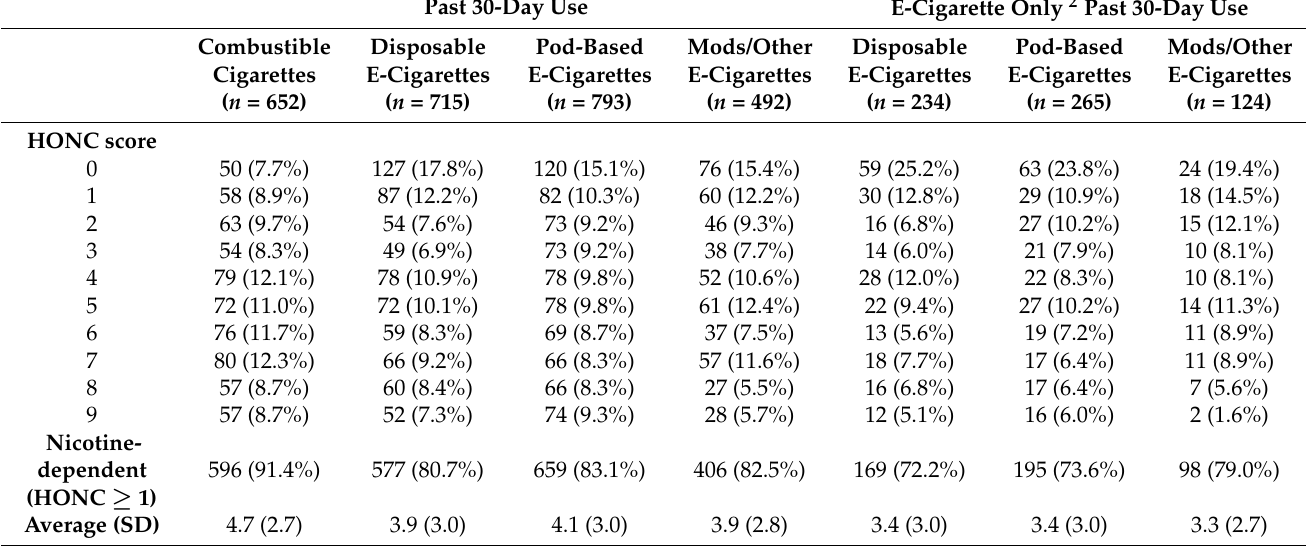
Table 1. HONC scores among past 30-day combustible cigarette and e-cigarette users, by device type ( n 1 ,